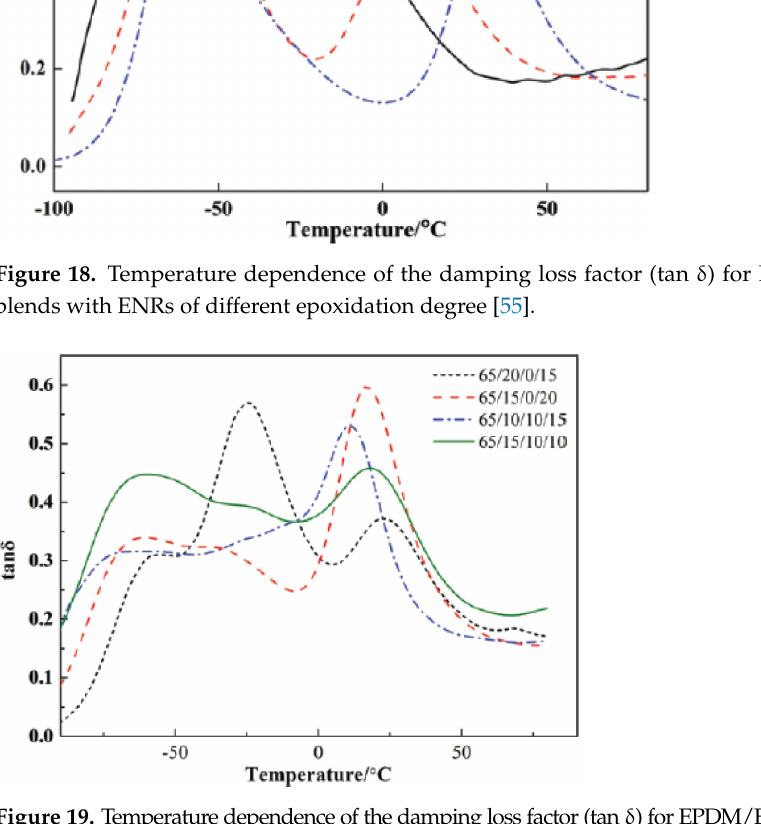
Figure 19. Temperature dependence of the damping loss factor (tan δ ) for EPDM/ENR50/ENR40/ENR25 multicomponent blends